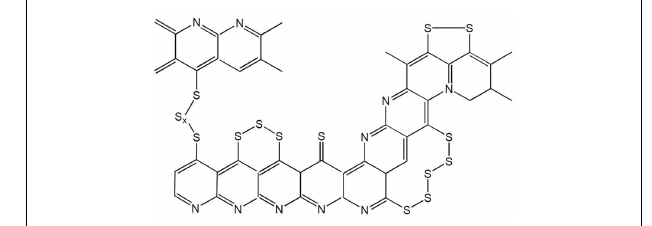
FIGURE 3 | General stages of PAN pyrolysis in medium temperature range .